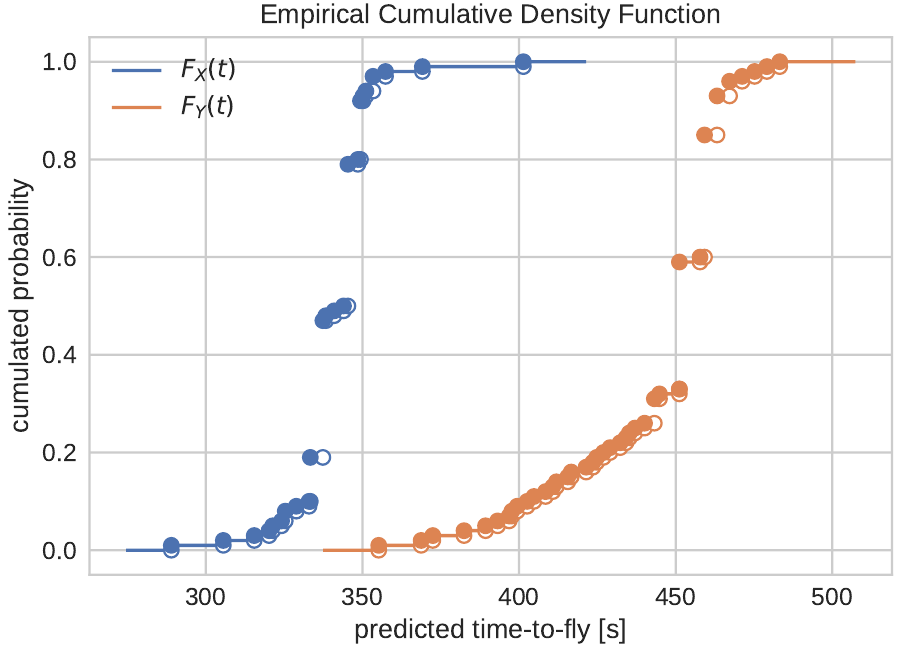
Figure 11. The right-continuous empirical cumulative distribution functions given by the QRF model as result of the time-to-fly predictions for two aircraft: leader ( F X ( t ) , blue) and follower ( F Y ( t ) ,